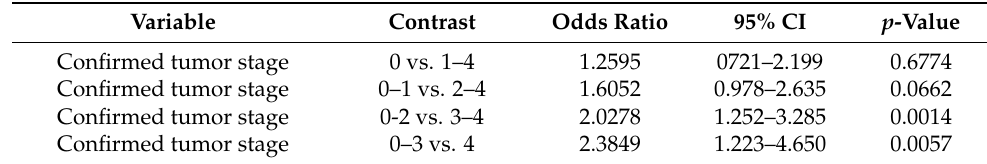
Table 3. Estimated marginal means for tumor stage (i.e., mean change contrasts for confirmed tumor stage).